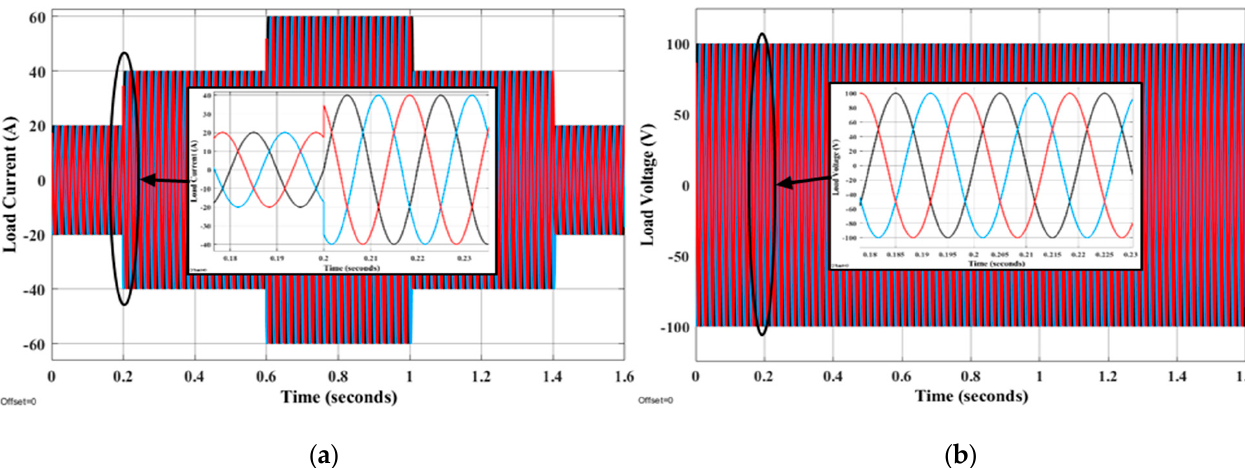
Figure 18. AC common bus current and voltage using the proposed technique under changing load conditions: ( a ) current and ( b ) voltage signal.